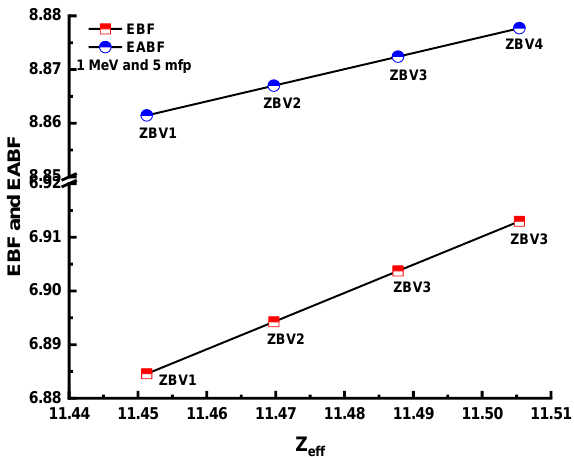
Figure 12. Variation of energy-absorption buildup factor (EABF) against glass compositions.